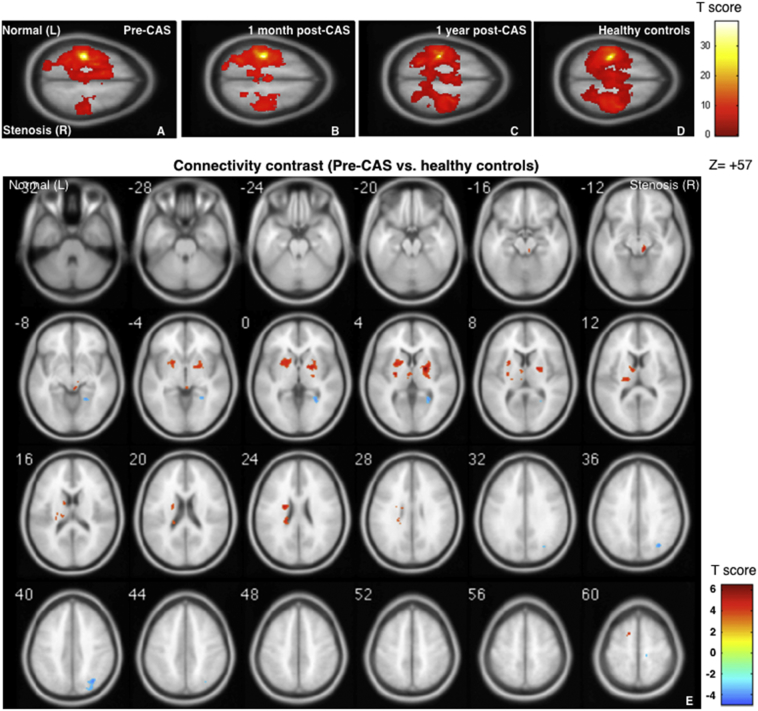
Group-level functional connectivity maps in the sensorimotor network (SMN). Four sets of one-sample SMN, seed at left primary motor cortex (M1) [−36–25 57], radius = 4, family-wise error p < .05. From left to right: carotid stenosis patients before carotid artery stenting (CAS) (A), 1 month after CAS (B), 1 year after CAS (C), and healthy controls (HC) (D). Two-sample contrast map (Pre-CAS > HC) with AlphaSim corrected p < .05. Red blobs show hyper-connectivity and blue blobs show hypo-connectivity (E). (For interpretation of the references to color in this figure legend, the reader is referred to the web version of this article.)